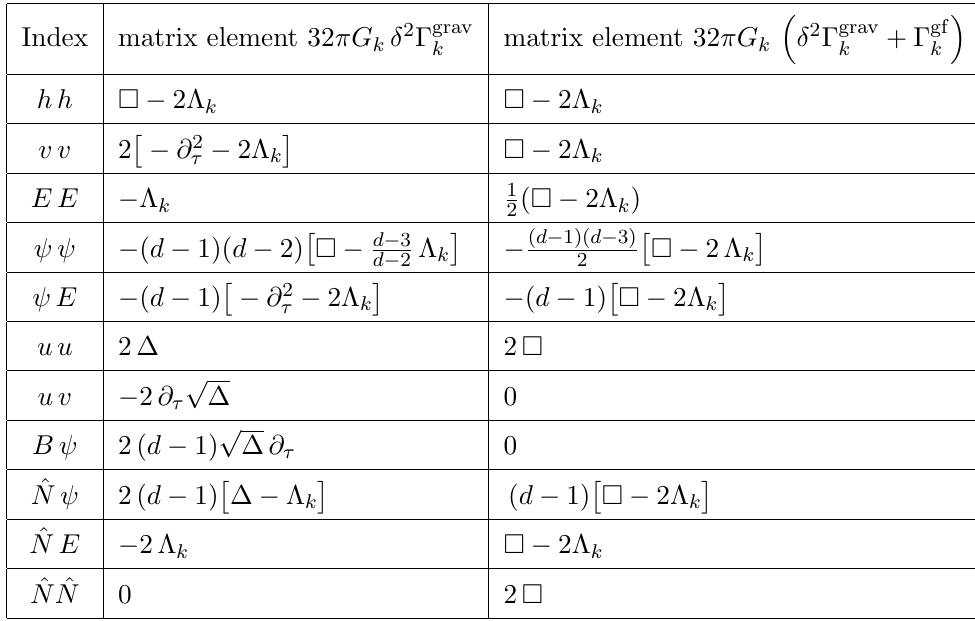
Table 1 . Summary of the matrix elements appearing in (cid:14) 2 (cid:0) k when expanded (cid:0) k around (cid:13)at Euclidean space. The column \index" identi(cid:12)es the corresponding matrix element in (cid:12)eld space, (cid:1) (cid:17) (cid:0) (cid:22) (cid:27) ij @ i @ j is the Laplacian on the spatial slice, and (cid:3) (cid:17) (cid:0) @ 2 entry there is a second contribution involving the adjoint of the di(cid:11)erential operator and the order of the (cid:12)elds